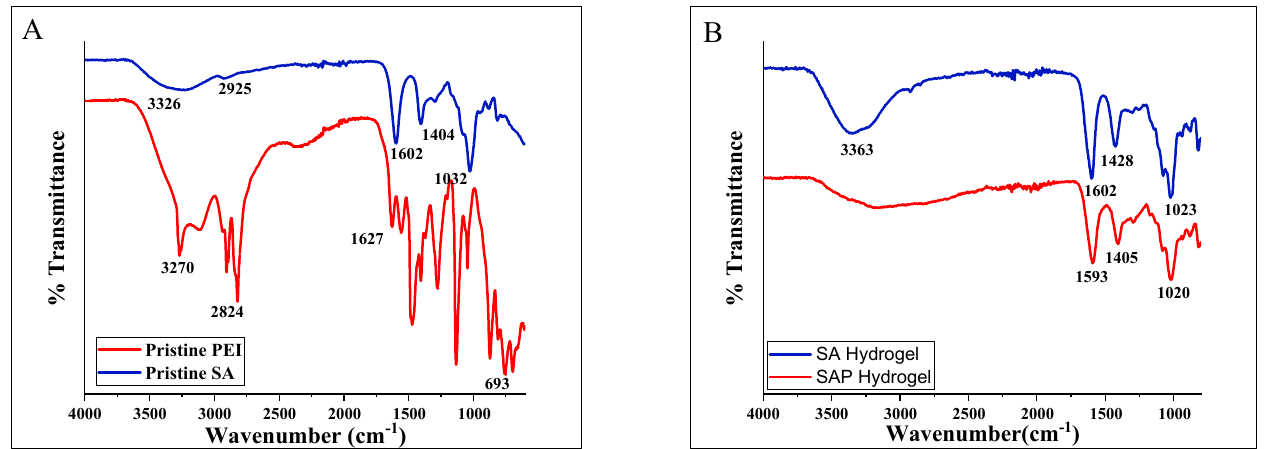
Figure 3. Fourier transform infrared (FTIR) spectra of ( A ) sodium alginate (blue trace) and polyethyleneimine (red trace), and ( B ) sodium alginate hydrogel (SA) and PEI modified sodium alginate hydrogel discs (SAP).